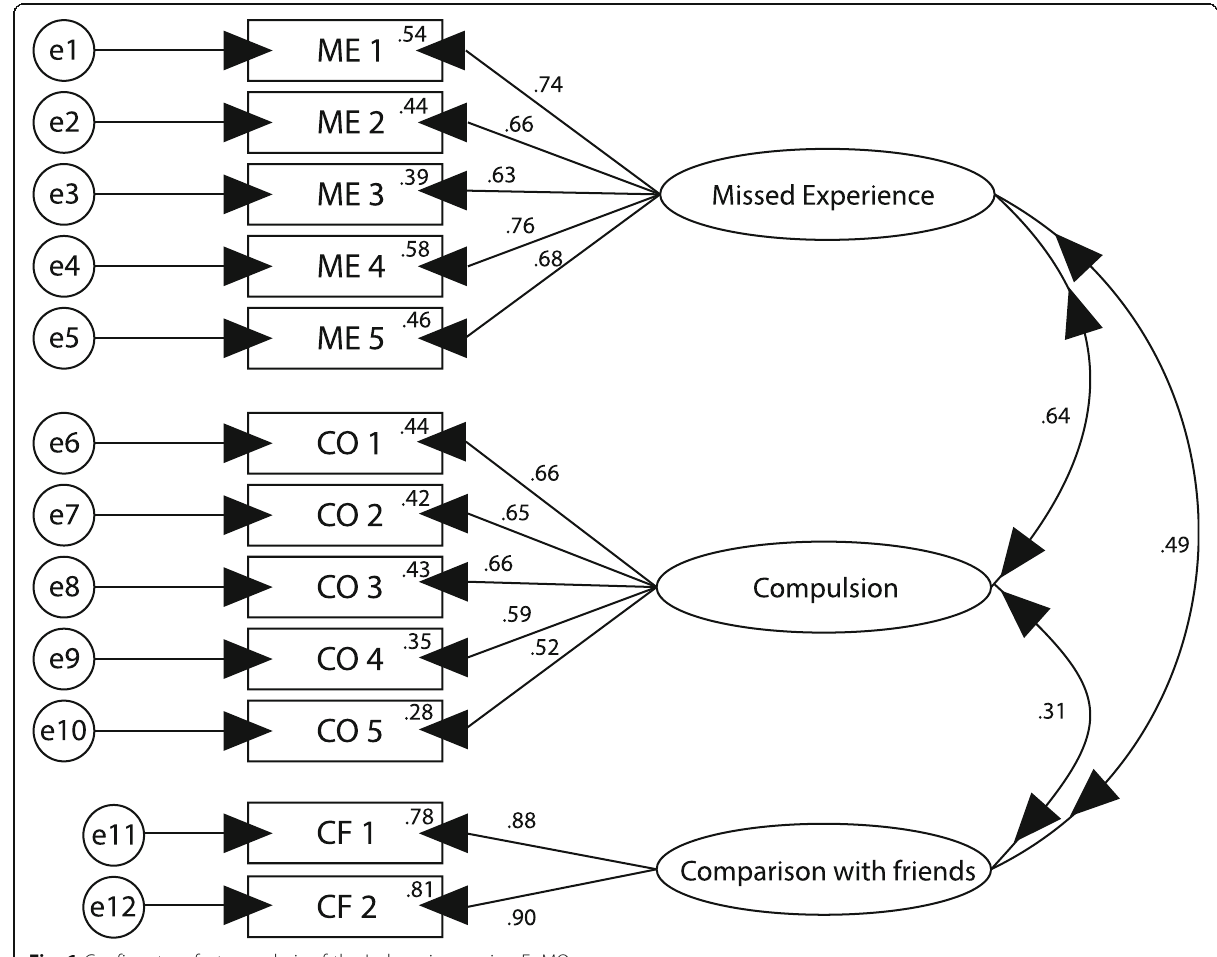
Fig. 1 Confirmatory factor analysis of the Indonesian version FoMO